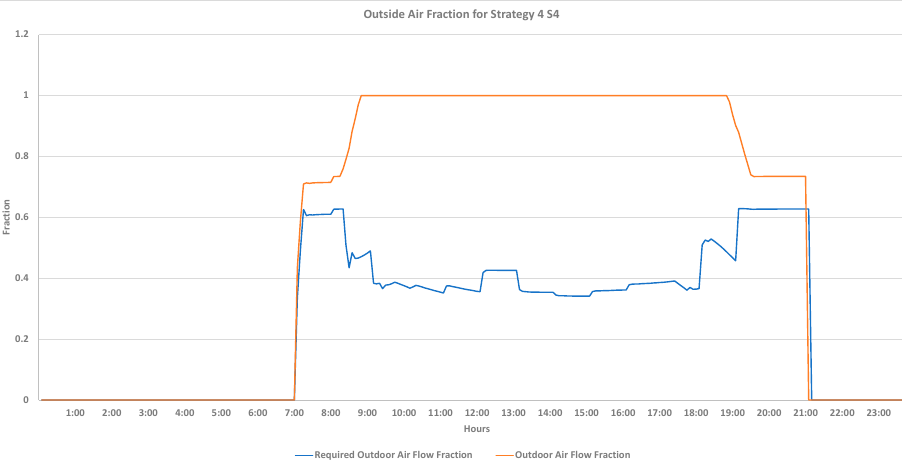
Figure 7. Fan power when the strategies S3, S4, and S5 were applied.